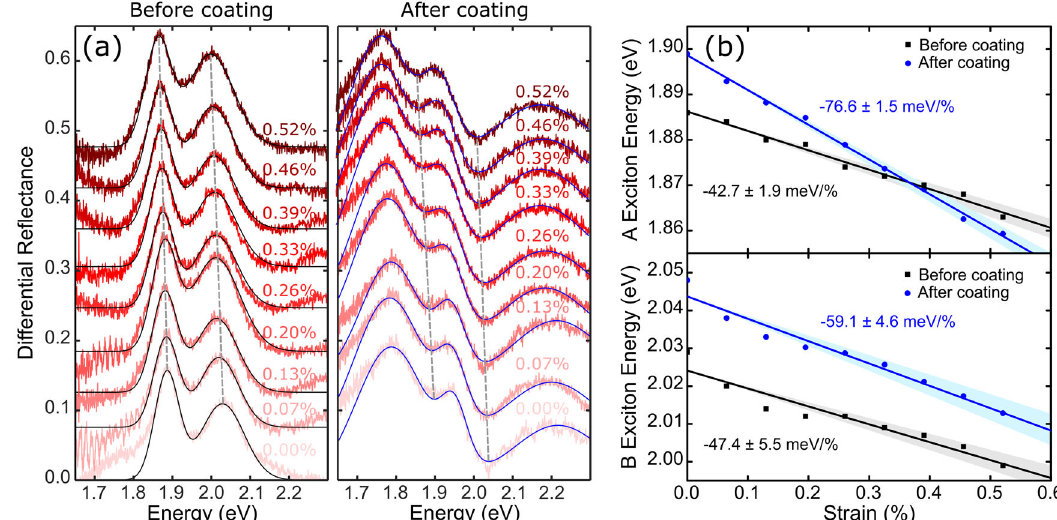
Fig. 2 Strain tunable re fl ectance. a Differential re fl ectance spectra at different uniaxial strain values of a single-layer MoS 2 fl ake before and after adamantane plasma polymer encapsulation. b A and B exciton energies at different uniaxial strain values before and after adamantane plasma polymer encapsulation. The data has been fi t to a straight line to extract the gauge factor value (solid line). The shaded area around the solid line indicates the uncertainty of the fi